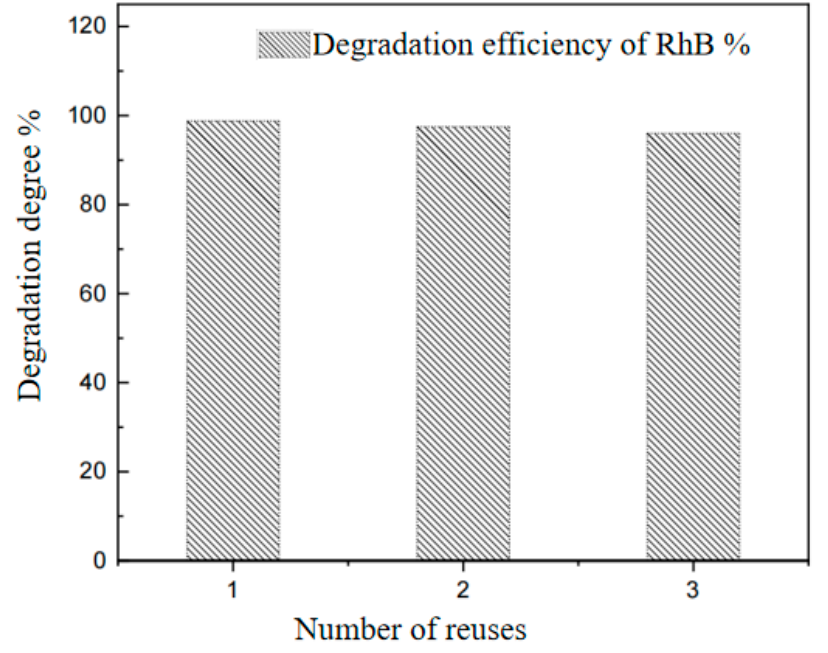
Figure 7. The removal rate of RhB in recycling. (Reactor: pH at 4.5, MIL-53(Fe)@CF photocatalytic membrane 150 mg, RhB 1 mg/L, H 2 O 2 1 mmol/L).